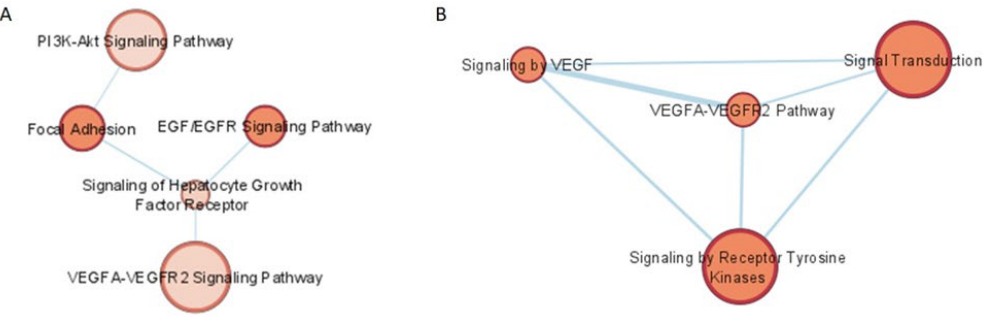
Figure 3. Enriched pathways interaction. The target genes of the three validated miRNAs with differential expression in the serum were used as input for enrichment analysis in the KEGG, Reactome, and Wikipathways databases. The VEGF-related pathways were enriched in Wikipathways ( A ) and Reactome ( B ).